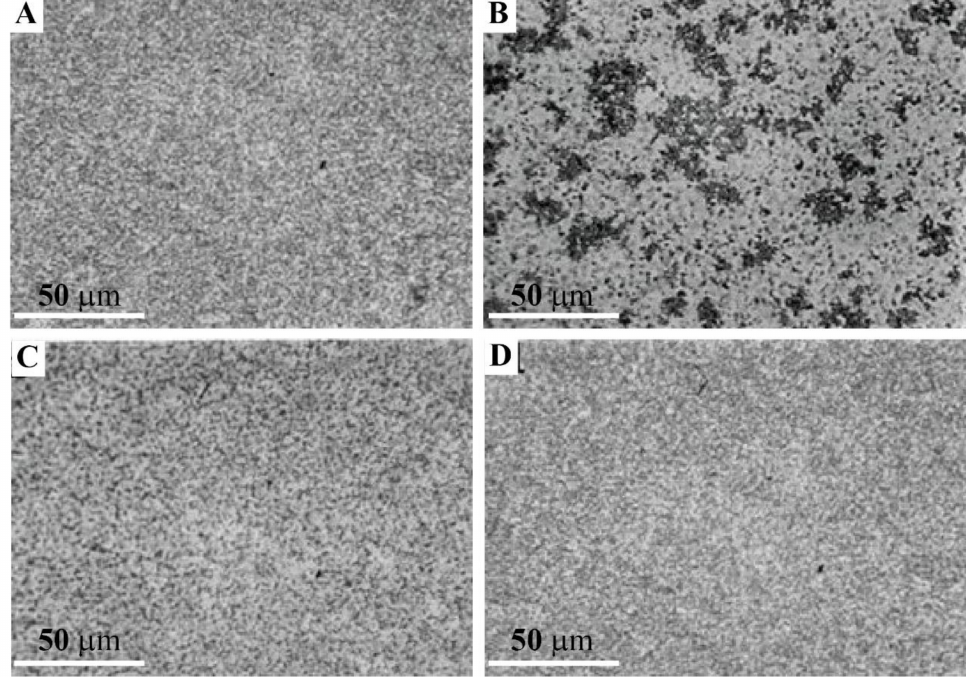
Figure 6. Intermolecular glycan–glycan binding of g580 glyconectin glycans demonstrated by adhesion of g580 coated beads. Aggregation of 100 µ L 2% bead suspension: ( A ) g580 glyconectin glycans coated beads in the absence of physiological calcium ions (CMF-ASW—buffered with 10 mM Tris pH 7.2), ( B ) g580 glyconectin glycans coated beads in the presence of physiological calcium ions (SWT—buffered with 10 mM Tris pH 7.2), ( C ) g580 glyconectin glycans coated beads in the presence of physiological calcium ions (SWT—buffered with 10 mM Tris pH 7.2) with Fab monovalent fragments of the anti-GN1 Block 2 monoclonal antibodies (100 µ g/mL), and ( D ) non coated beads in the presence of physiological calcium ions (SWT—buffered with 10 mM Tris pH